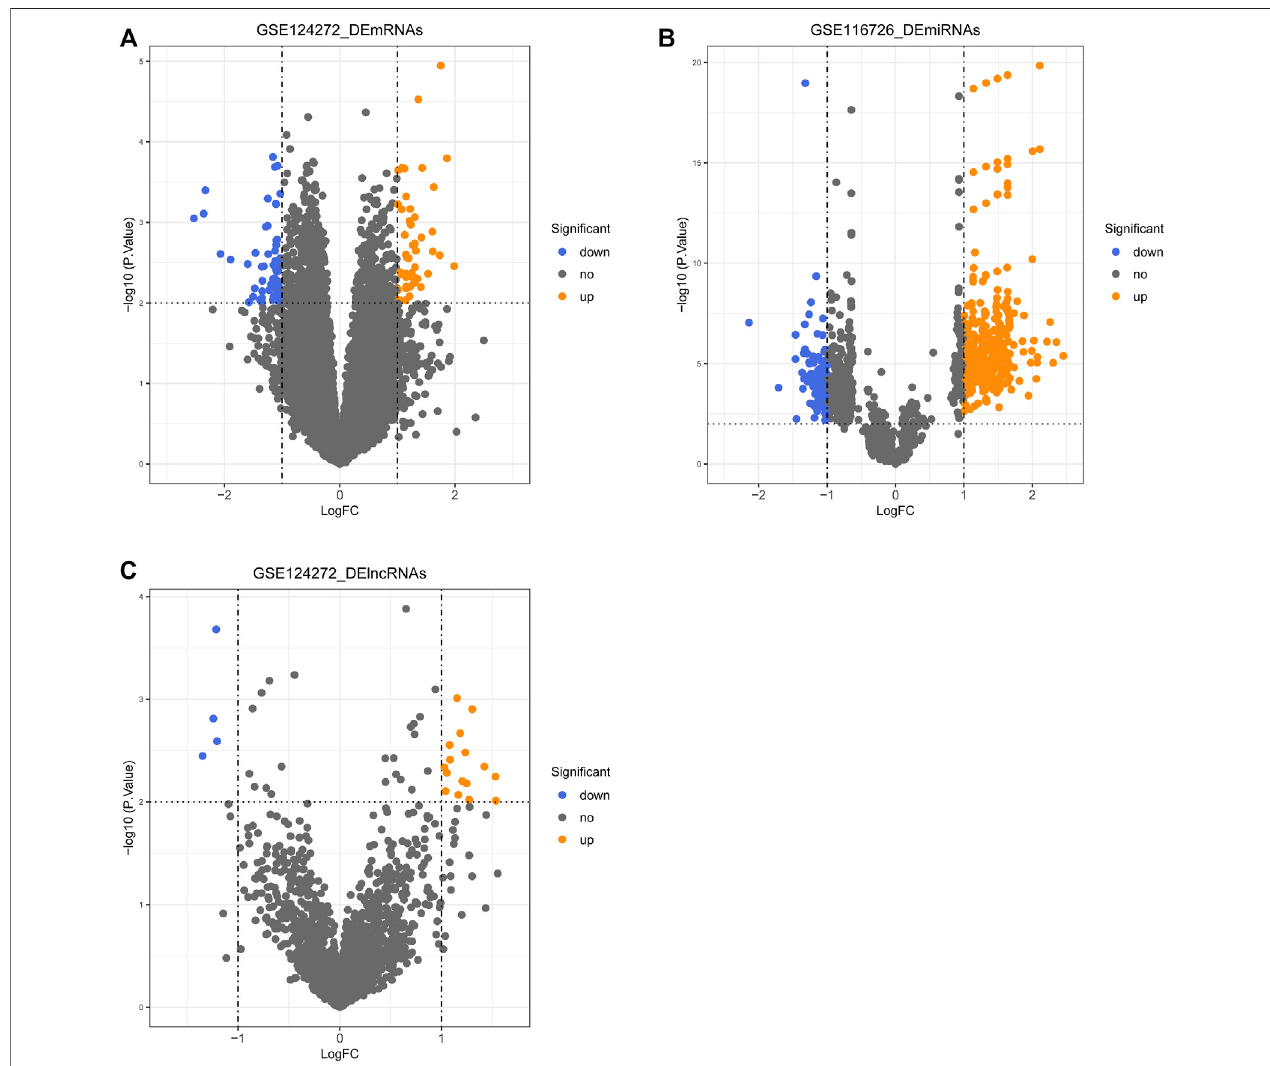
FIGURE 1 | Volcano plot of differentially expressed genes (DEGs), lncRNAs (DE-lncRNAs), and miRNAs (DE-miRNAs) in the IDD group compared with the control group. (A) Volcano plot of DE-mRNAs. (B) Volcano plot of DE-lncRNAs. (C) Volcano plot of DE-miRNAs.